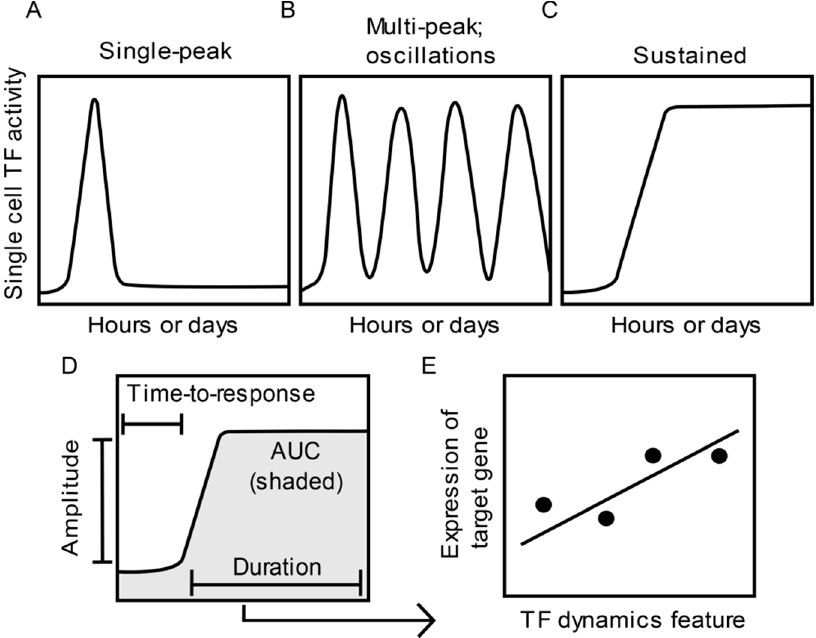
Figure 1. Features of single cell transcription factor (TF) dynamics and their impact on gene expression. ( A – C ) Example patterns of single cell TF dynamics observed in response to stimuli. ( D ) Quantitative features that characterize TF dynamics. ( E ) Assessment of the relationship between a feature of TF dynamics ( D ) and the expression of a target gene across different treatment or experimental groups.